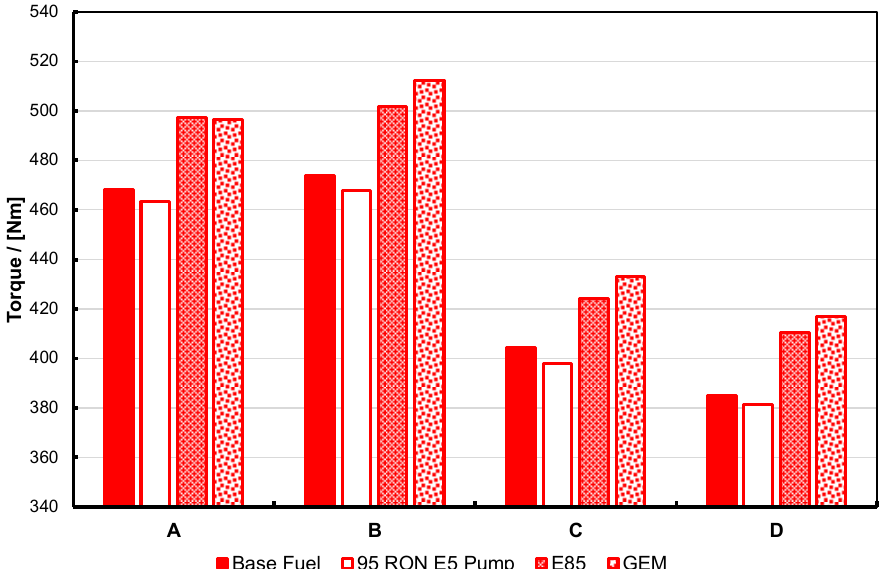
Figure 8. Maximum torque for the base and 95 RON pump gasolines, E85 and the GEM blend, at four different fixed-intake conditions, operated at KLSA ignition timing. For description of the test operating points, labelled A to D here, see Table 3 and text. Note that the two high-alcohol blends have nearly-matched stoichiometry and enthalpy of vaporization, RON and MON, and as a consequence perform in an essentially identical manner.